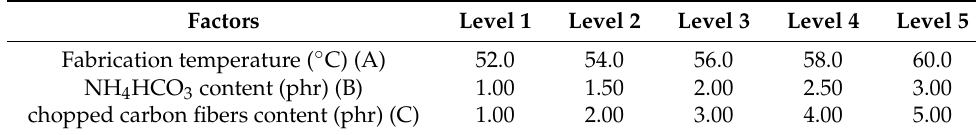
Table 3. Factors and levels of orthogonal